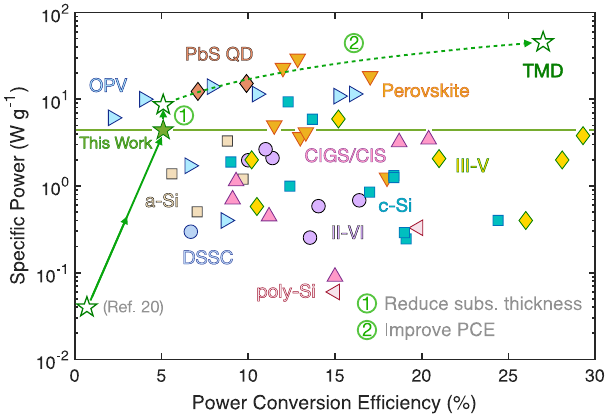
Fig. 5 Power conversion ef fi ciency (PCE) and speci fi c power (power per weight) of lightweight and fl exible thin- fi lm solar technologies. Our fl exible TMD